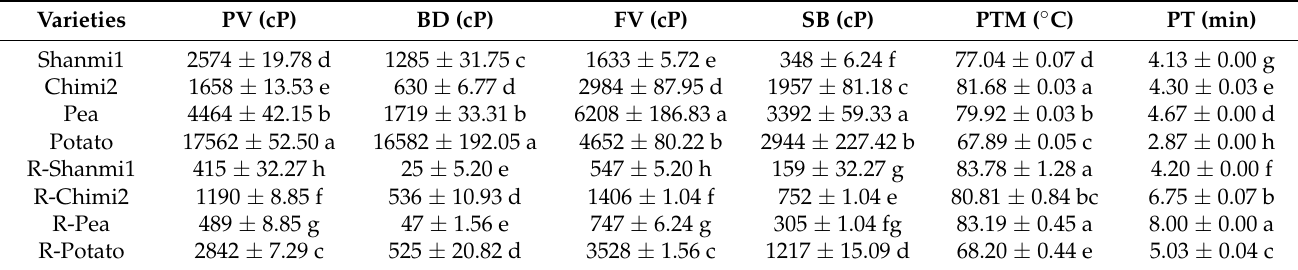
Table 4. Pasting and thermal properties of NS (natural starch) and RS (resistant